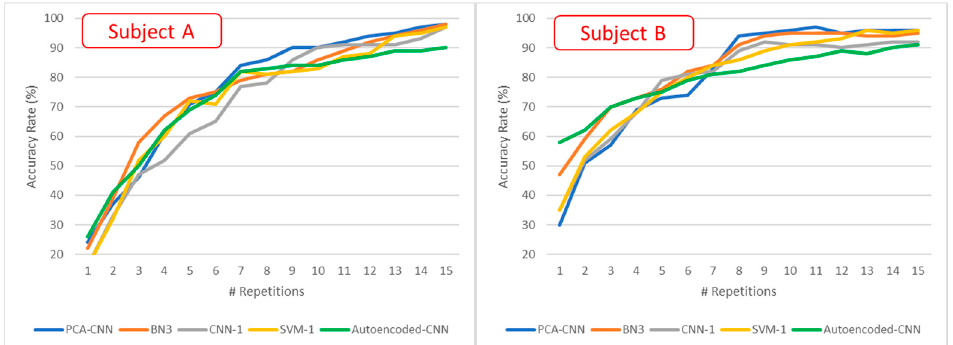
Figure 7. Accuracy rate on subjects A and B for Dataset 2.